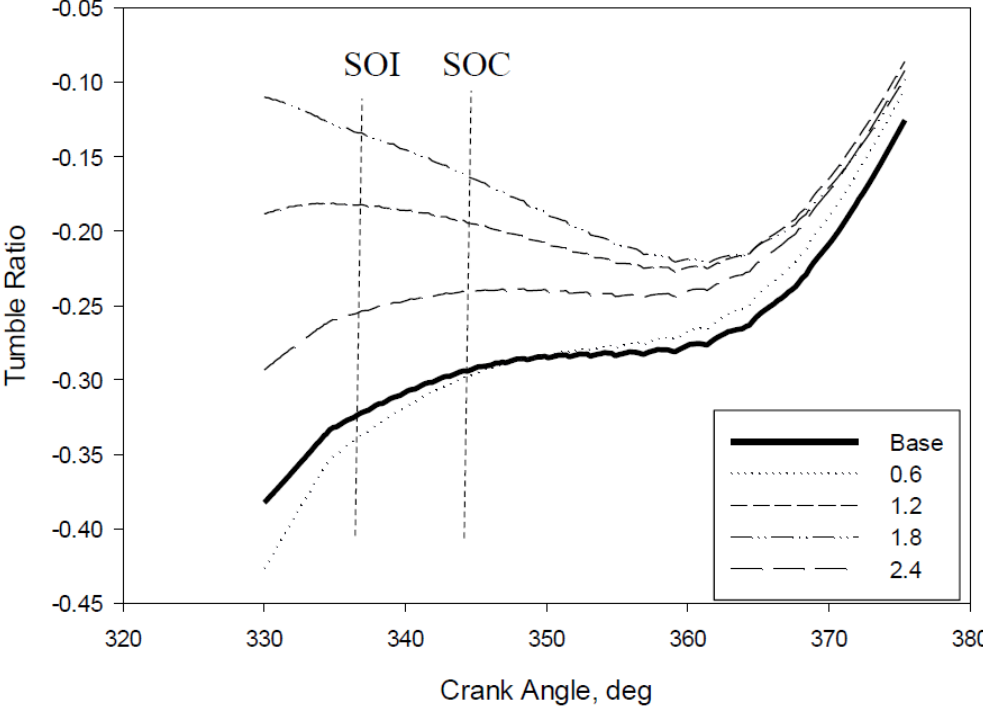
Figure 10. The plot of the tumble ratio against the crank angle.